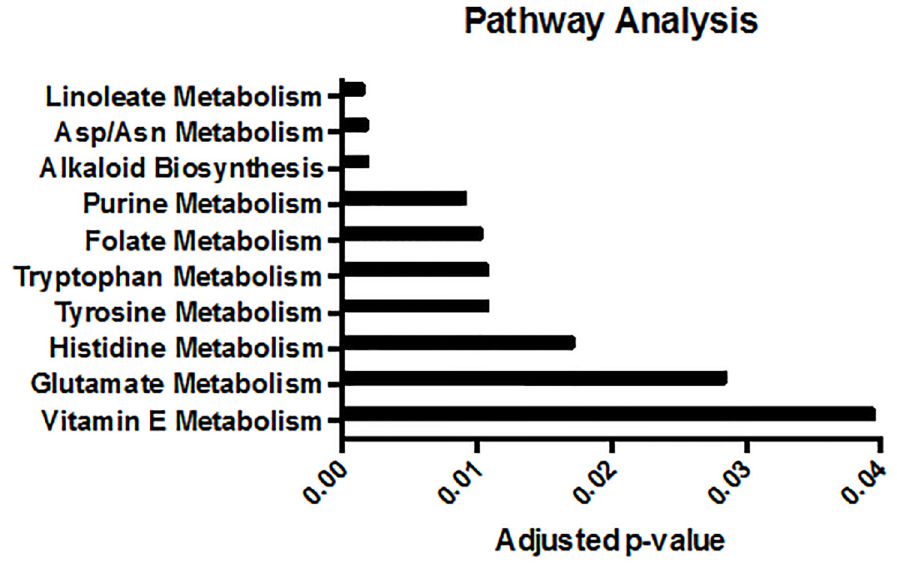
Fig 3. Significantly perturbed metabolic pathways in AUD subjects. Pathway analysis identified linoleate metabolism as the most significantly perturbed pathway in the BALF from AUD subjects.